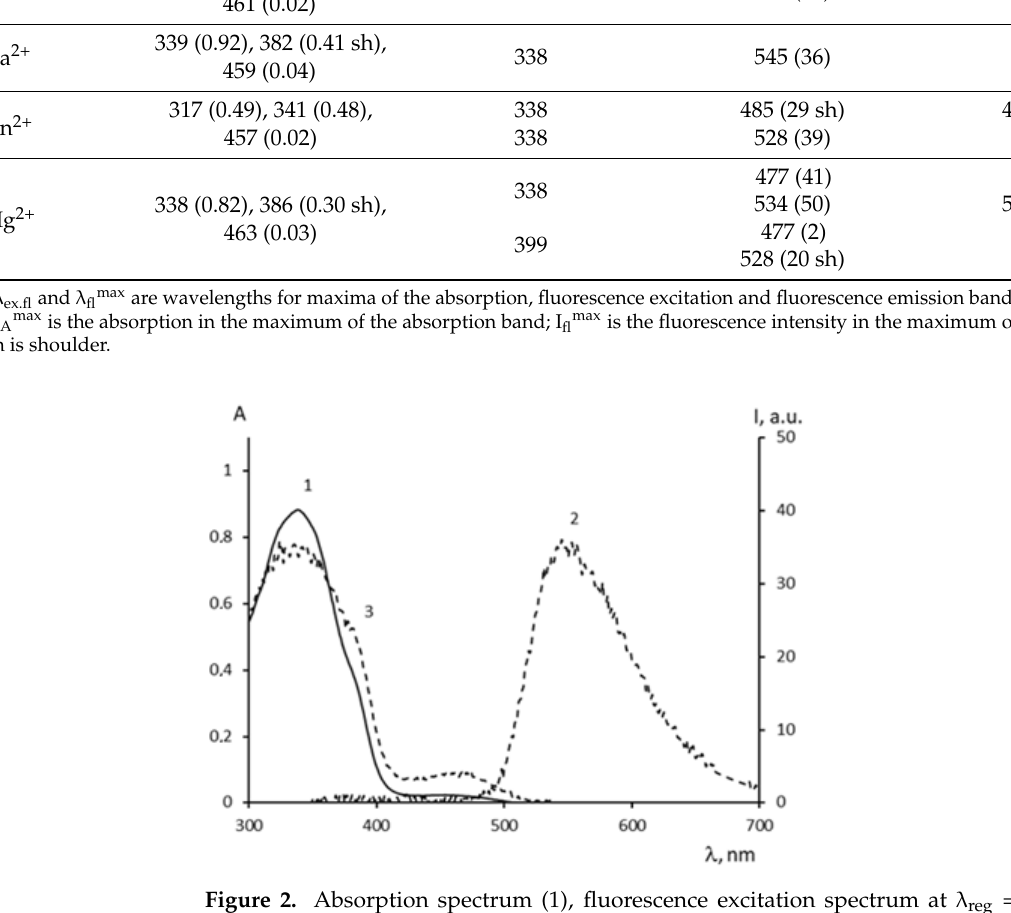
Figure 2. Absorption spectrum (1), fluorescence excitation spectrum at λ reg = 549 nm (3) and fluorescence spectrum at λ ex = 338 nm (2) of compound 3 in the mixed solvent solution.